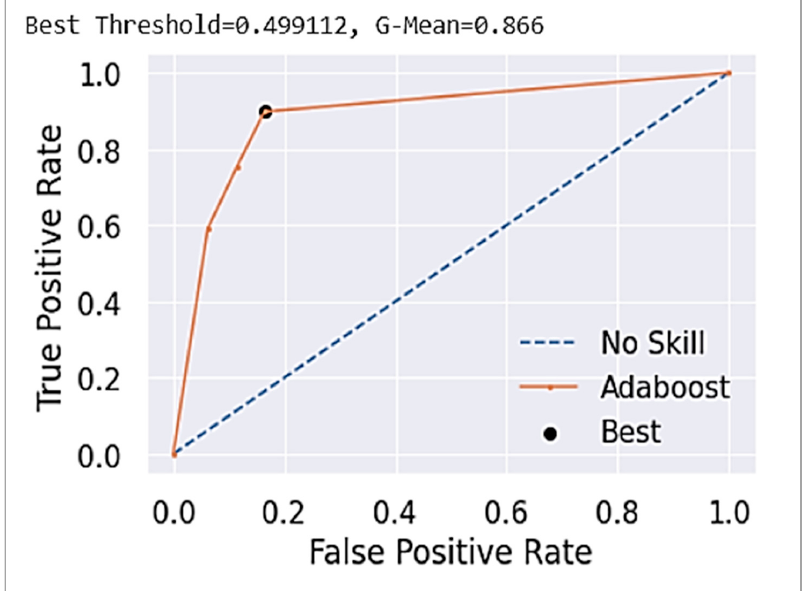
Figure 9. ROC Curve for Ensemble (Adaboost) random forest model.